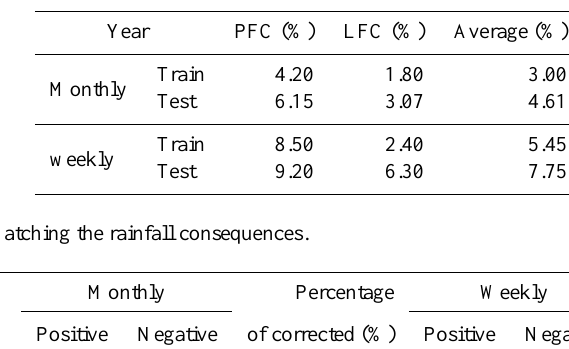
Table 4. IDNN performance based on the peak and low flow error criteria for monthly and weekly forecasting.